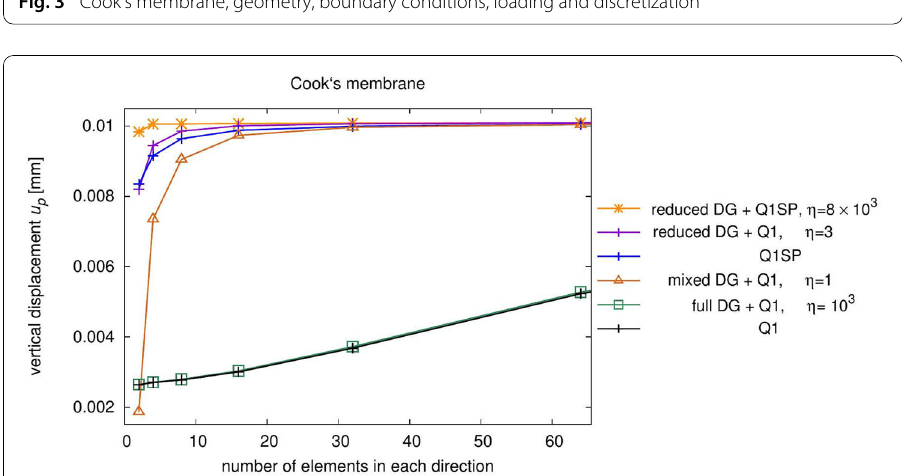
Fig. 4 Vertical displacement of the point P as a function of the number of elements in each direction for Q1, Q1SP, DG and their